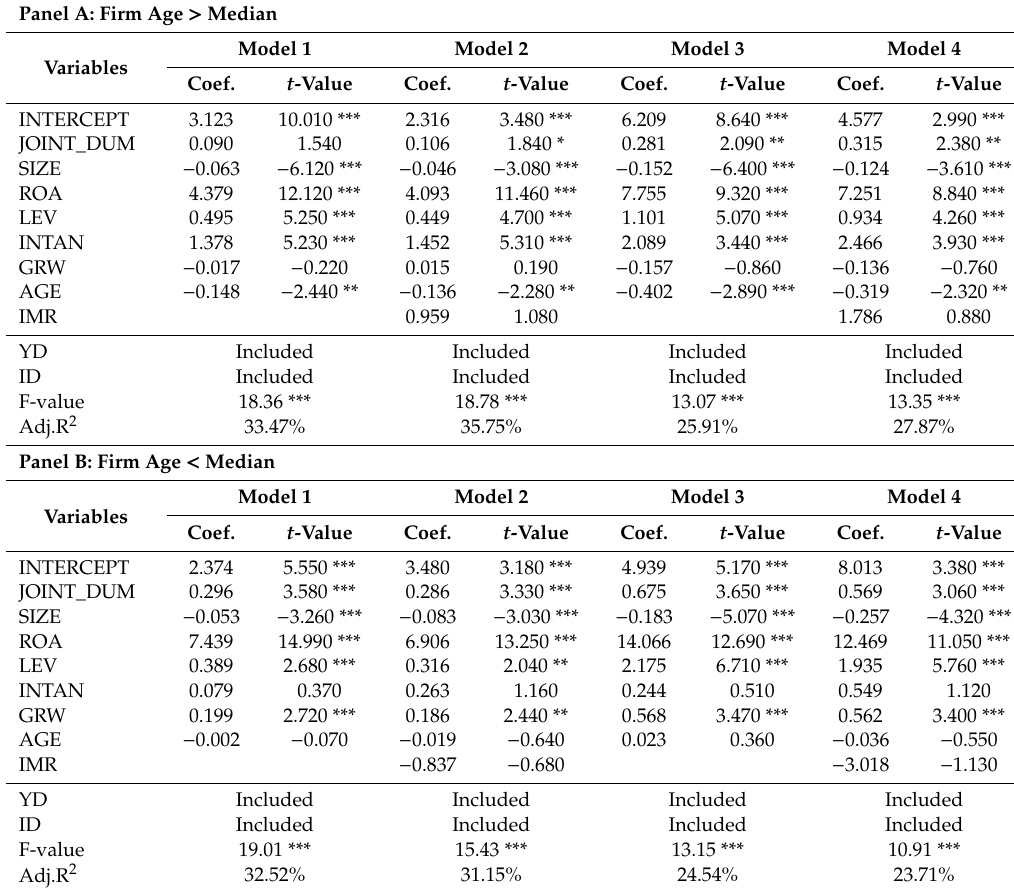
Table 13. Analysts’ cash flow forecast issuance and firm